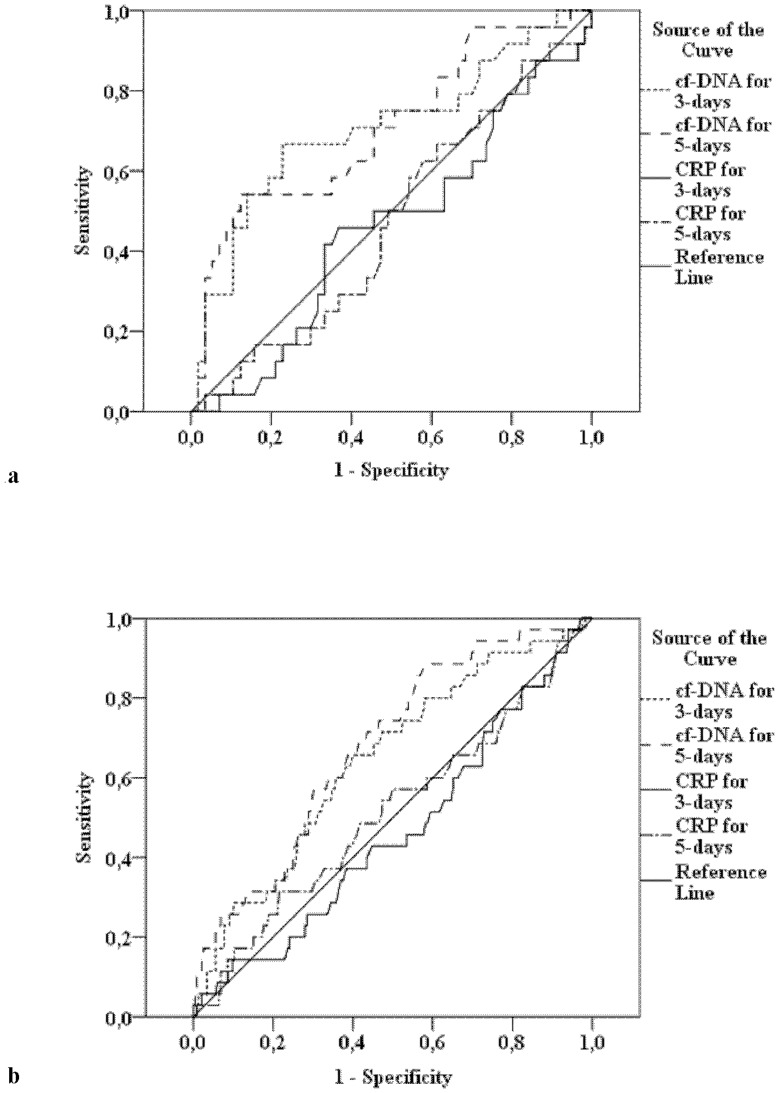

a: Receiver operating characteristic (ROC) curves for cf-DNA and C-reactive protein (CRP) for predicting 90-day mortality in patients with Staphylococcus aureus bacteraemia (SAB) treated in intensive care unit (ICU) during 7 days of documented bacteraemia (N = 99). The area under the curve (AUC) for the day 3 cf-DNA was 0.71 (95% CI 0.57–0.84) (p<0.01) with cut-off value of 1.99 µg/ml with sensitivity of 67% and specificity of 77%. For day 5 cf-DNA, the AUC was 0.71 (0.58–0.84) (p<0.01) with cut-off value of 1.69 µg/ml with sensitivity of 63% and specificity of 60%. The corresponding AUC for day 3 CRP was 0.46 (0.32–0.59) (p = 0.55) and for day 5 CRP 0.47 (0.34–0.61) (p = 0.67). b: Receiver operating characteristic (ROC) curves for cf-DNA and CRP for predicting 90-day mortality in patients with Staphylococcus aureus bacteraemia (SAB) without treatment in intensive care unit (ICU) during 7 days of documented bacteraemia (N = 319). The area under the curve (AUC) for day 3 cf-DNA was 0.64 (95% CI 0.55–0.74) (p<0.01) and cut-off value of 1.57 µg/ml with sensitivity of 62% and specificity of 61%. For day 5 cf-DNA, the AUC was 0.68 (0.59–0.77) (p<0.01) with cut-off value of 1.49 µg/ml with sensitivity of 65% and specificity of 61%. The corresponding AUC for day 3 CRP was 0.46 (0.36–0.57) (p = 0.48) and for day 5 CRP 0.51 (0.41–0.62) (p = 0.80).